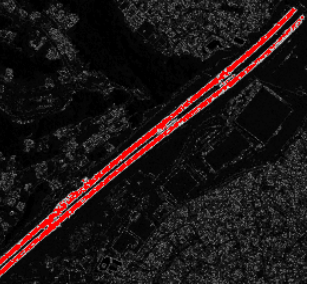
The results detected the same stretches of